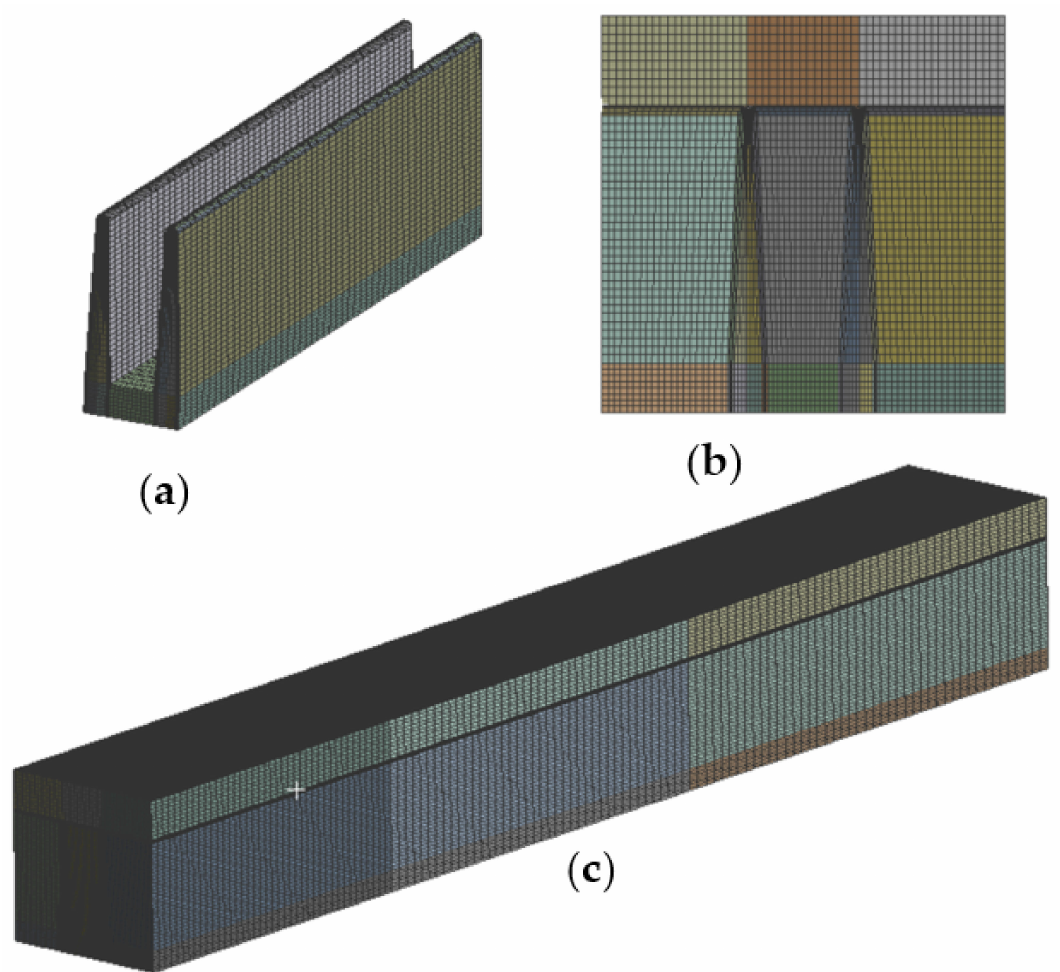
Figure 3. Computational domain. ( a ) Heat sink, ( b ) section view of heat sink and air domain, and ( c ) air